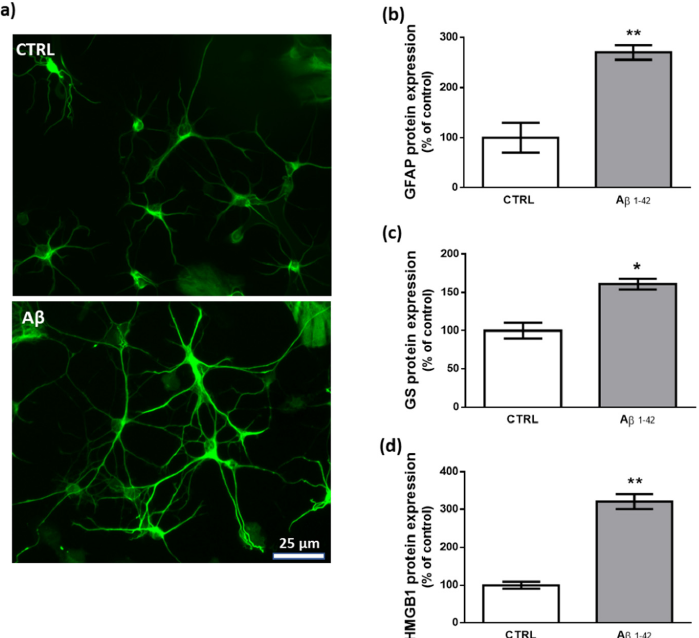
Figure 2. Effects of A β 1-42 on astrocytes. ( a ) Representative photomicrographs of GFAP immuno- labeled cells. Results from western blot experiments show increased expression of GFAP ( b ), GS ( c ), and HMGB1 ( d ) in astrocytes treated with human fibrillary A β 1-42 1 μ m for 48 h compared with vehicle-treated cells (CTRL). Data are plotted as mean ± SEM and expressed as percentage variations vs. CTRL. * p < 0.05; ** p < 0.01 vs. CTRL (Student’s t -test).